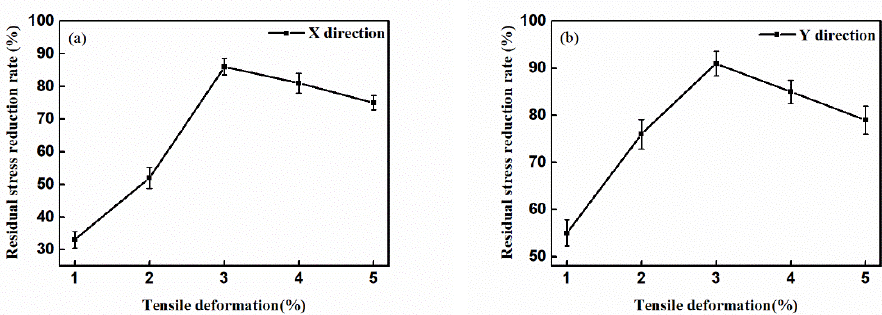
Figure 4. Reduction rates of residual stress at different tensile deformation: ( a ) Residual stress reduction rates in X direction; ( b ) Residual stress reduction rates in Y direction (The picture has been replaced with a higher quality).